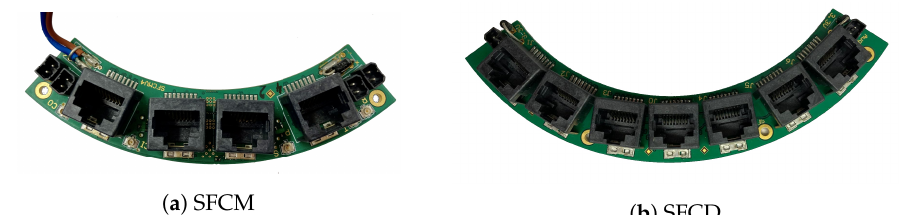
Figure 10. ( a ) The SFCM PCB, featuring four RJ45 ports for fast signal distribution. Three coaxial cable connections receive fast signals from a master board, which are distributed to two SFCD PCBs. ( b ) The SFCD features one input connector in the center and six outputs to distribute the signals from the SFCM to the